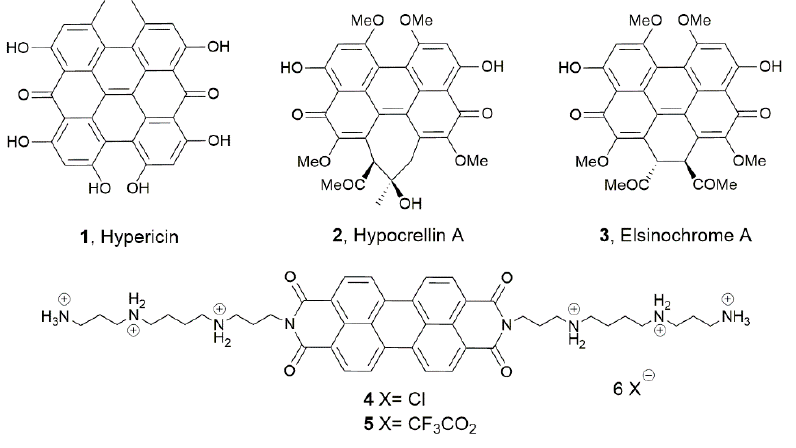
Figure 1. Examples of antifungal perylene-based compounds 1–3 and tested molecules 4 and 5 .